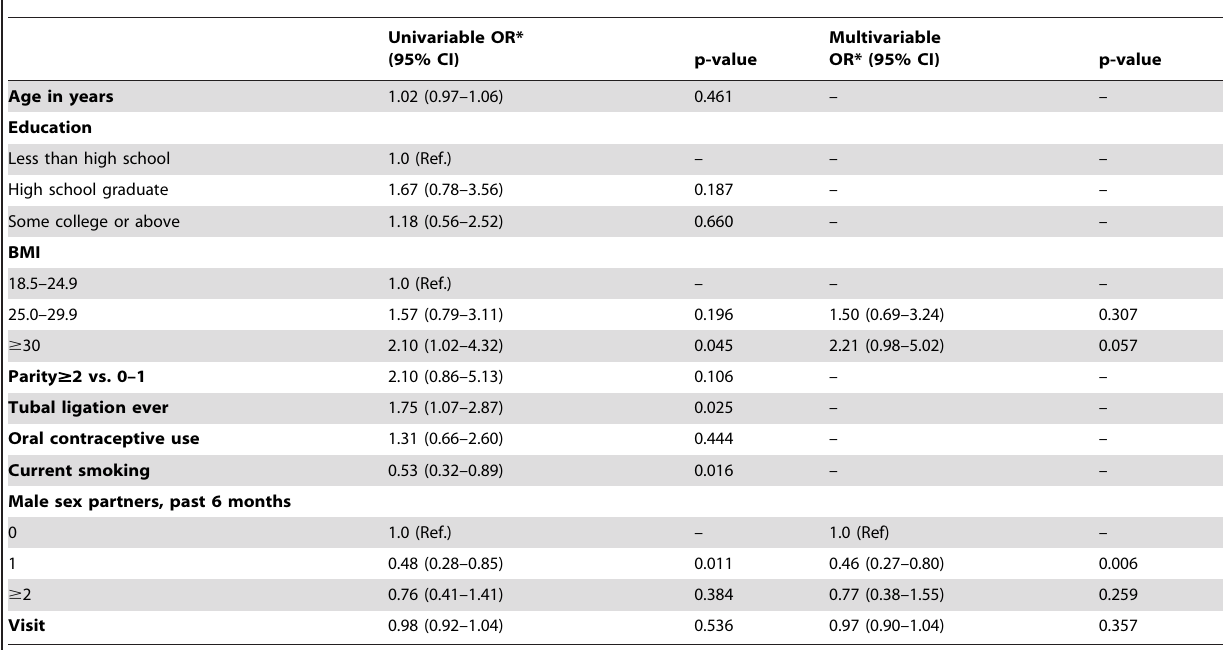
Table 2. Factors Associated with High Glycogen ( . 0.026 m g/ m l), N= 177 visits.